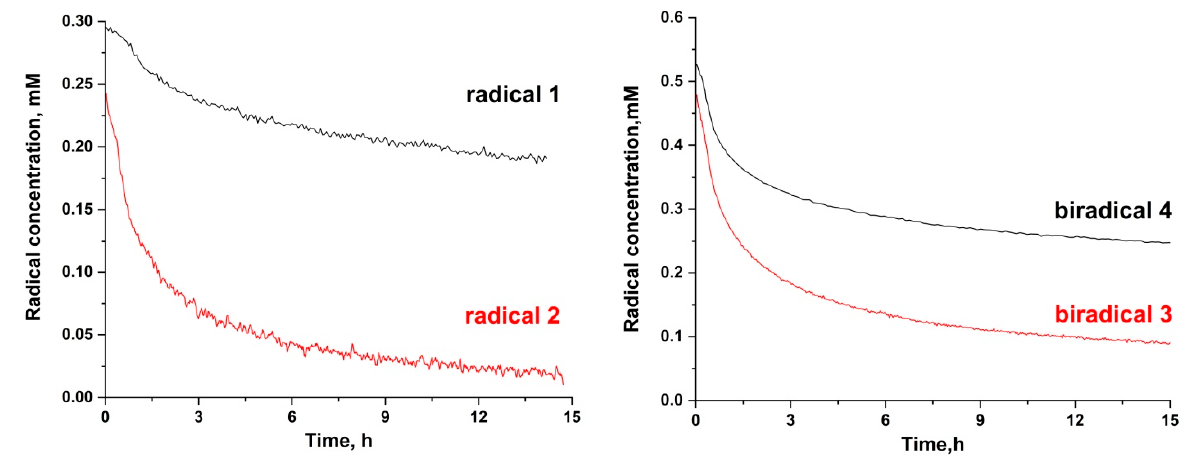
Figure 6. Kinetics of decay of radicals 1 – 4 in the presence of 0.1 M ascorbate in PBS at pH 7.4. It is known that for highly stable nitroxides, the kinetics of reduction are complicated [45] and determined not only by the rate of nitroxide reduction but also by an equilibrium with hydroxylamine and the presence of a nascent ascorbate anion. Thus, to prevent the accumulation of the ascorbate anion, we chose the same approach as in the paper by Bobko et al. [43], and 2 mM glutathione was added into the solution. The initial part (60–120 min) of the kinetics of the decay was approximated to a mono-exponential function to calculate pseudo-first-order rate constants k obs (Equation (1)):